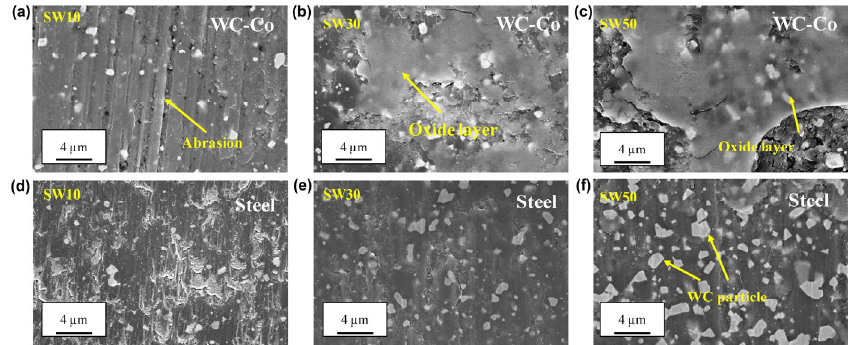
Fig. 10 SEM images of worn surfaces of SiC-WC composites against WC-Co and steel counterbodies at 20 N